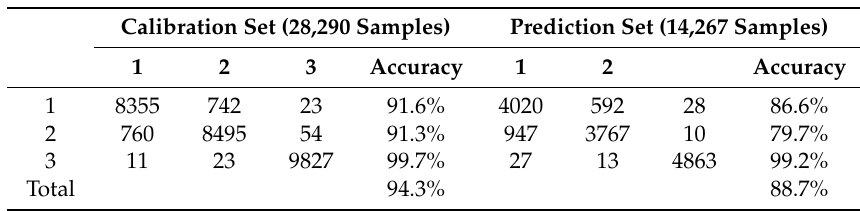
Table 1. Discriminant results of grape seed samples of three varieties by the support vector machine (SVM) model.